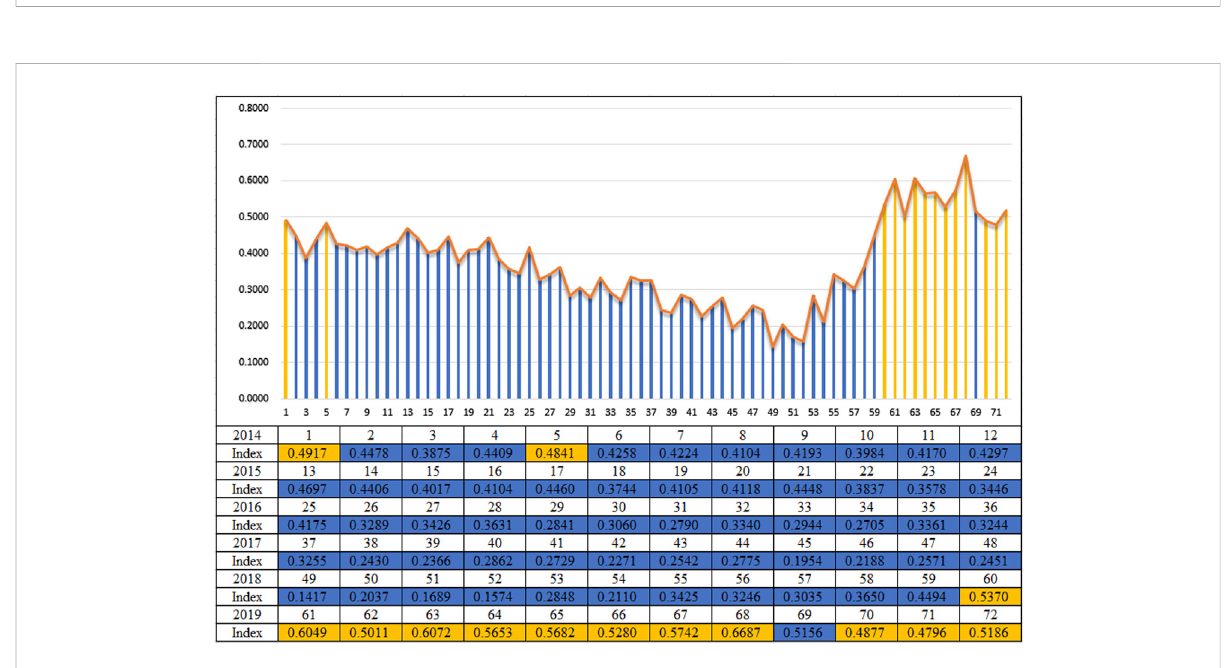
FIGURE 6 The monthly indexes in Changning play from 2014 to